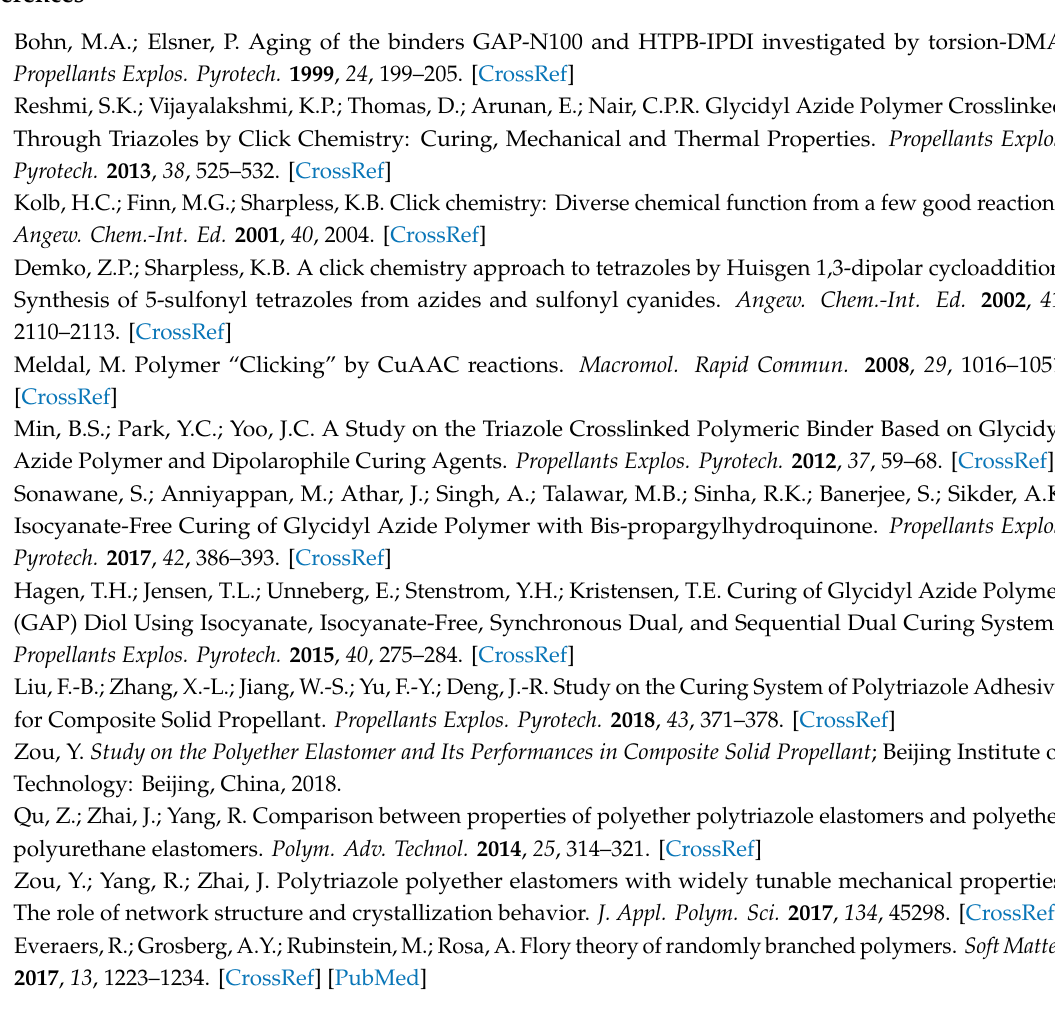
Figure S1: 1 H NMR analysis of N100- g -GAP, N100, and GAP, Figure S2: Stress–strain curves of the